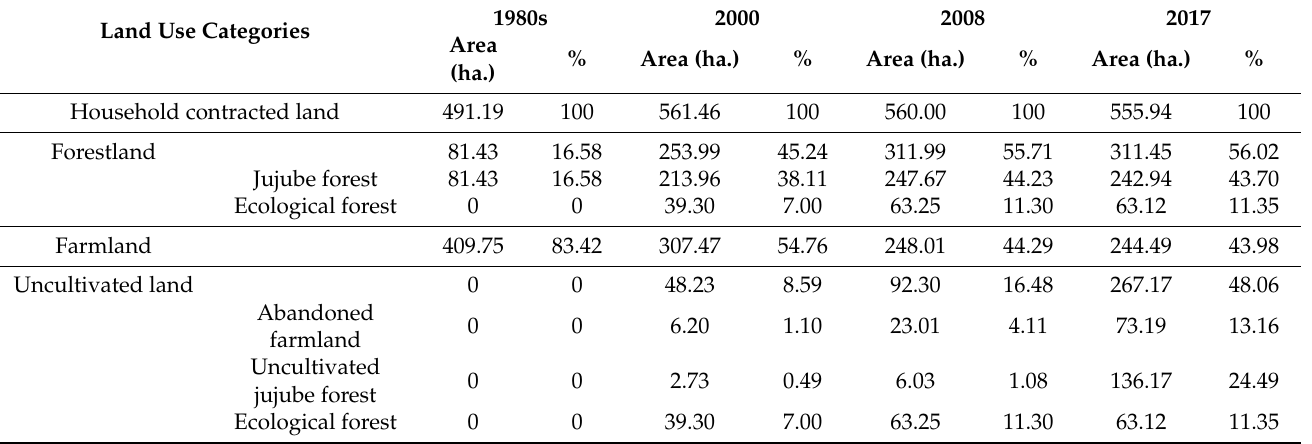
Table A3. Area and proportion of land use types contracted by 451 households from 1980s to 2017 in Jia